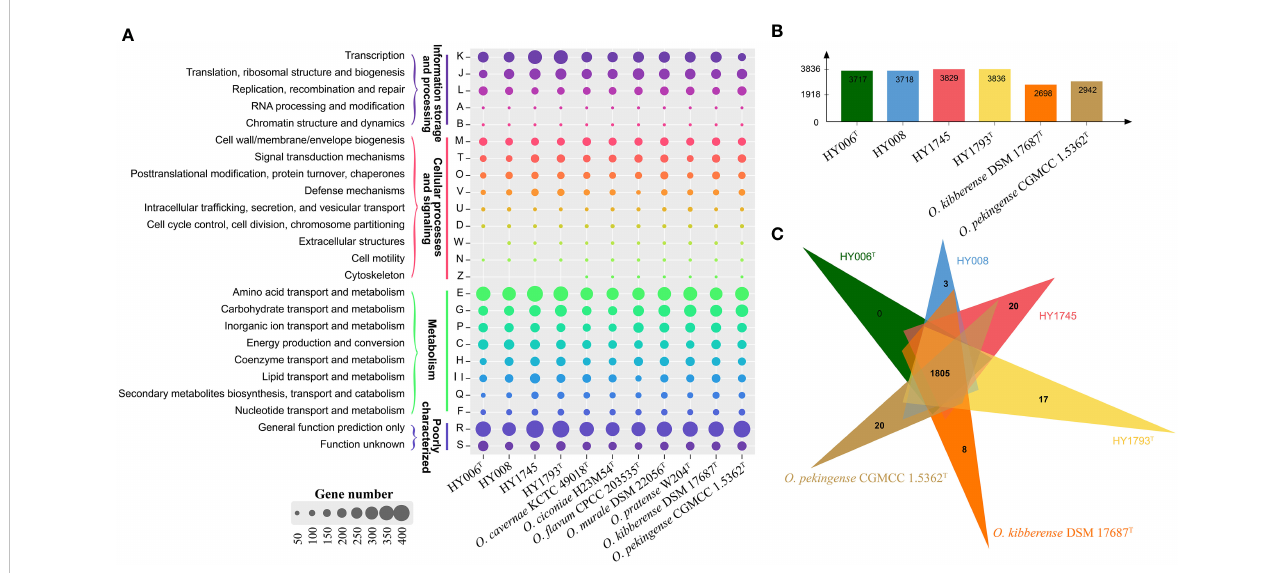
FIGURE 2 Whole-genome comparison and annotation of orthologous clusters across multiple strains. (A) Distributions of the COGs in the eleven sequenced genomes of genus Ornithinimicrobium ; (B) The number of clusters in each strain; (C) Venn diagram displays the distribution of shared orthologous clusters among the six